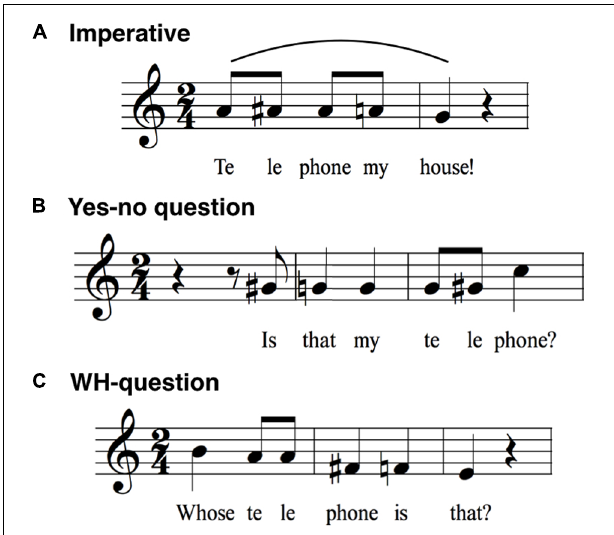
FIGURE 7 | Sentence modality. A comparison is made between (A) an imperative sentence, (B) a yes–no interrogative, and (C) a WH-interrogative. Of interest here is the absence of declination for the imperative statement in (A) , as well as the large terminal rise at the end of the yes–no interrogative in (B) .